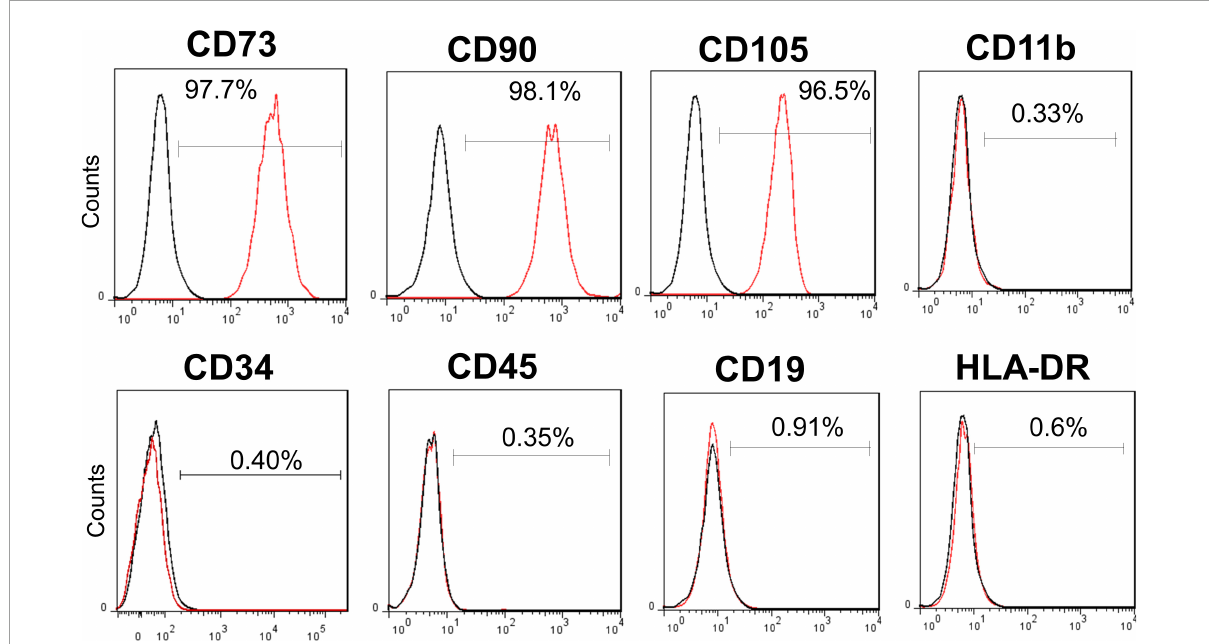
FIGURE1 Surface markers of allogenic human umbilical cord mesenchymal stem cell (hUC-MSC). Flow cytometry analysis of hUC-MSC showing the positive surface markers CD73, CD90, CD105 ( > 95%), and the negative markers CD11b, CD19, CD34, CD45, and HLA-DR (0.33%, 0.91%, 0.40%, 0.35%, and 0.6%, respectively). CD, cluster of differentiation; HLA-DR, major histocompatibility complex (MHC) II cell surface receptor of human leukocyte